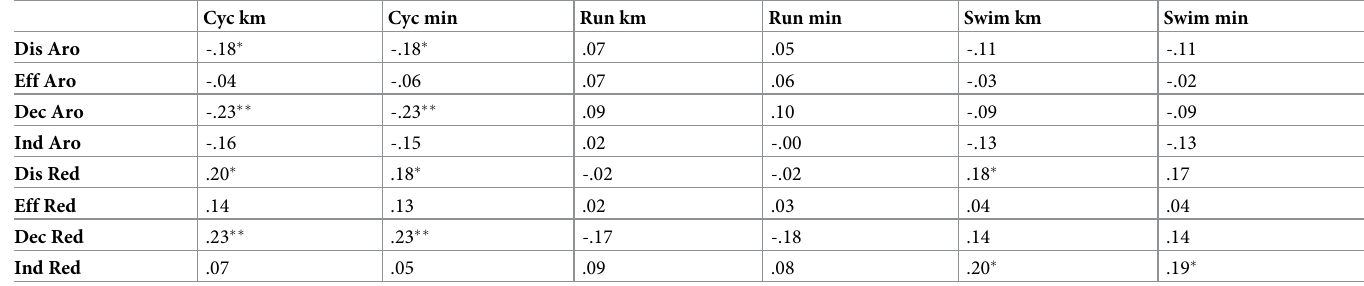
Table 2. Partial correlations of cycling, running, and swimming variables with dissonance variables controlling for gender and age (Study 1). Cyc km Cyc min